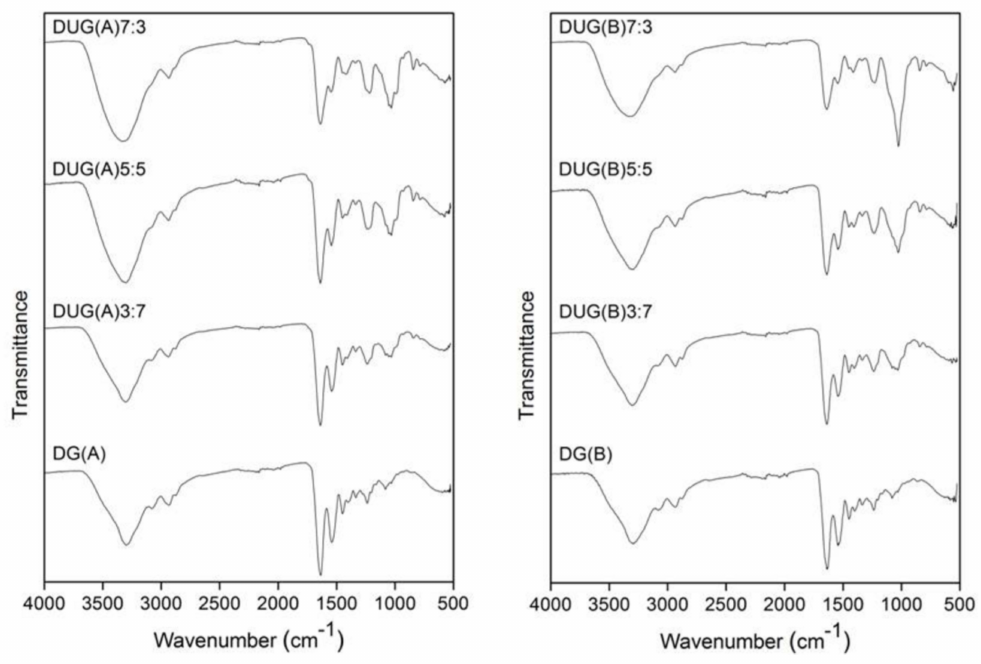
Figure 7. FTIR spectra of the recovered UG sca ff olds after incubation in PBS at 37 ◦ C for 96